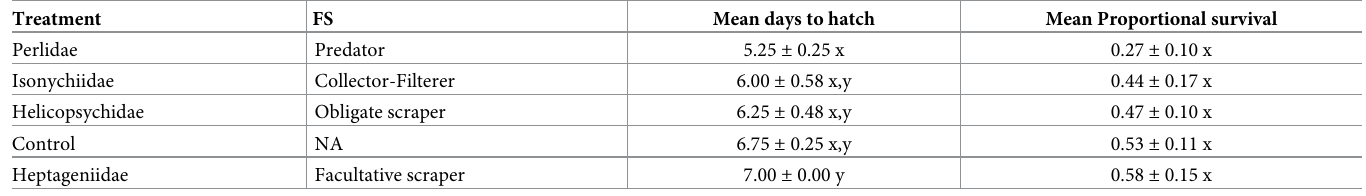
Table 2. Mean days ( ± SE) to hatch and mean proportional survival ( ± SE) at hatch for lake sturgeon free embryos across aquatic insect feeding specialization (FS) treatments.